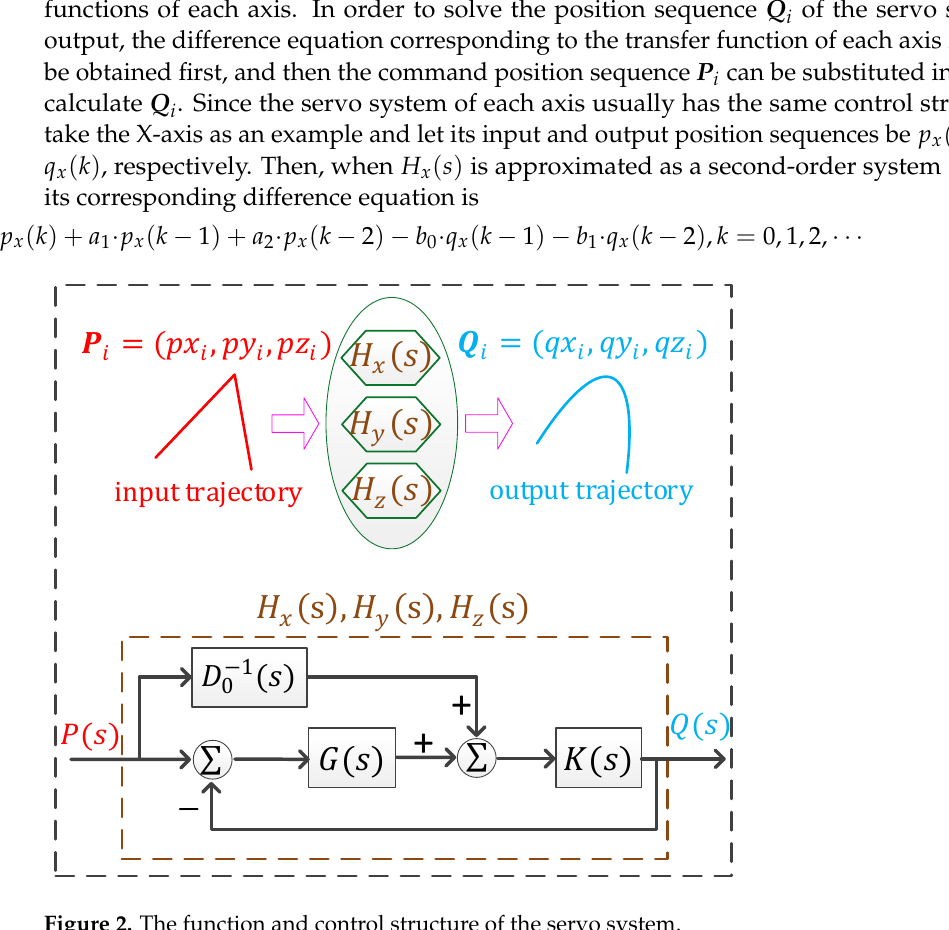
functions of each axis. In order to solve the position sequence Q